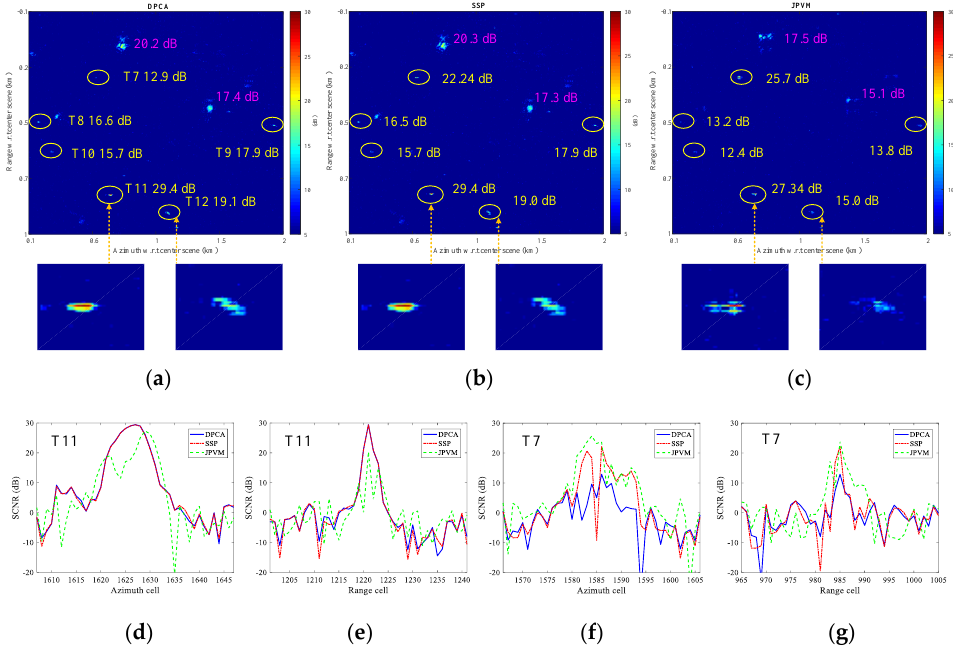
Figure 16. Clutter suppression comparison results (without multilook): ( a ) displaced phase center antenna (DPCA); ( b ) SSP; ( c ) joint pixel vector method (JPVM); ( d ) azimuth cut of Target 11; ( e ) range cut of Target 11; ( f ) azimuth cut of Target 7; and ( g ) range cut of Target 7.